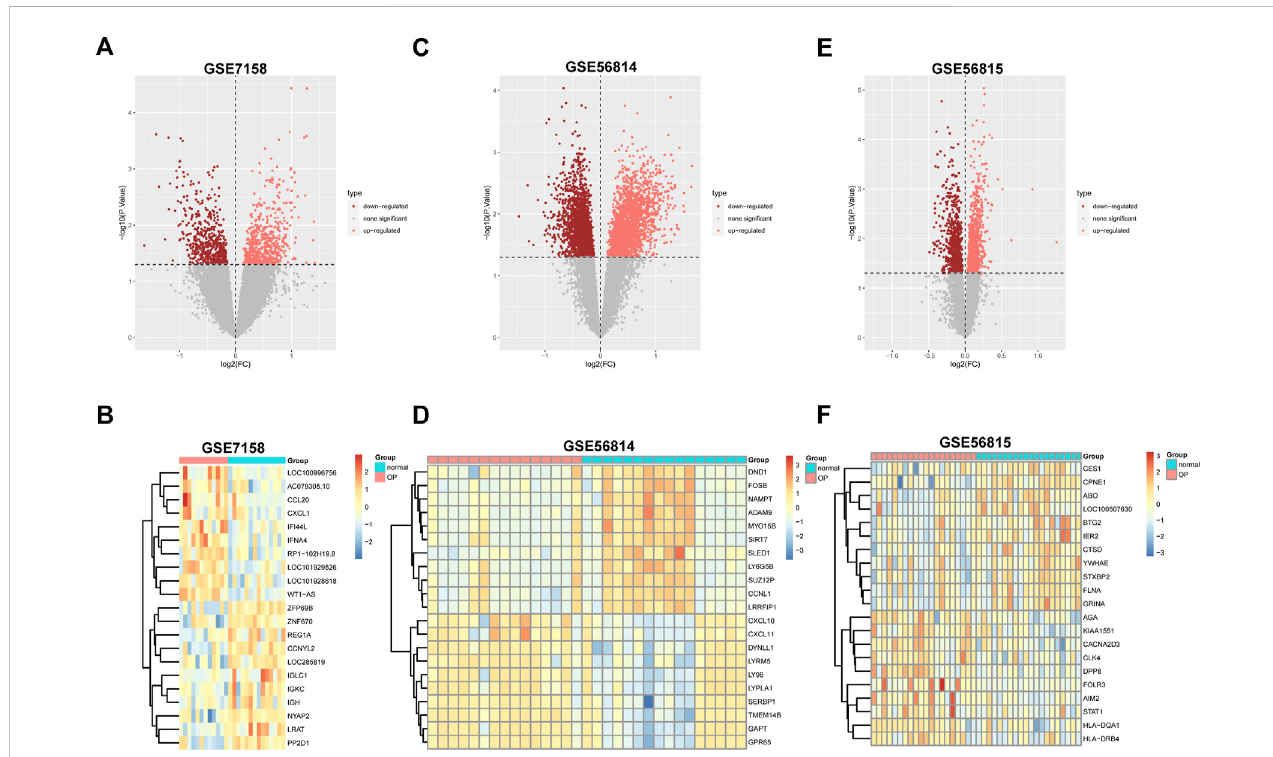
FIGURE 1 Identi fi cationofdifferentiallyexpressedgenesbetweenOPandnormalsamples.Volcanoplotsofthedifferentialgeneexpressiondatafrom (A) GSE7158, (C) GSE56814, and (E) GSE56815. In the volcano plots, the pink points show upregulated genes (adjusted p -value < 0.05), whereas the red points represent downregulatedgenes.Heatmapofthetop10differentiallyexpressedgenesbasedon (B) GSE7158, (D) GSE56814,and (F) GSE56815.Thecolorintensity(from red to blue) suggests the higher to lower expression. FC